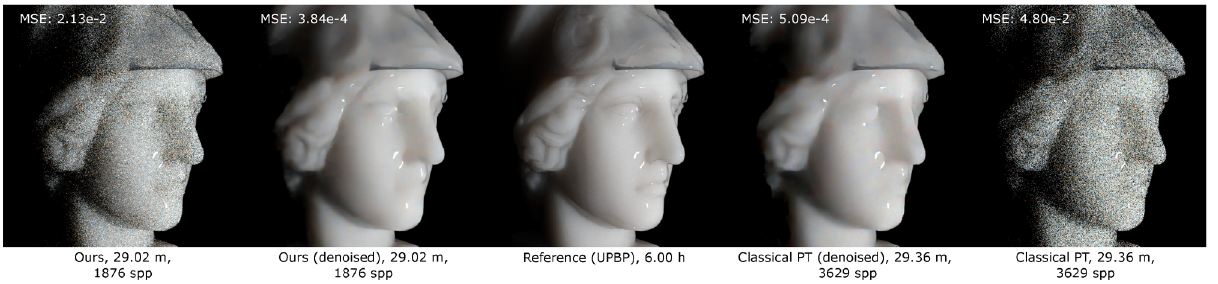
Fig. 12 Comparison of our method and path tracing with equal time for the Athena scene.